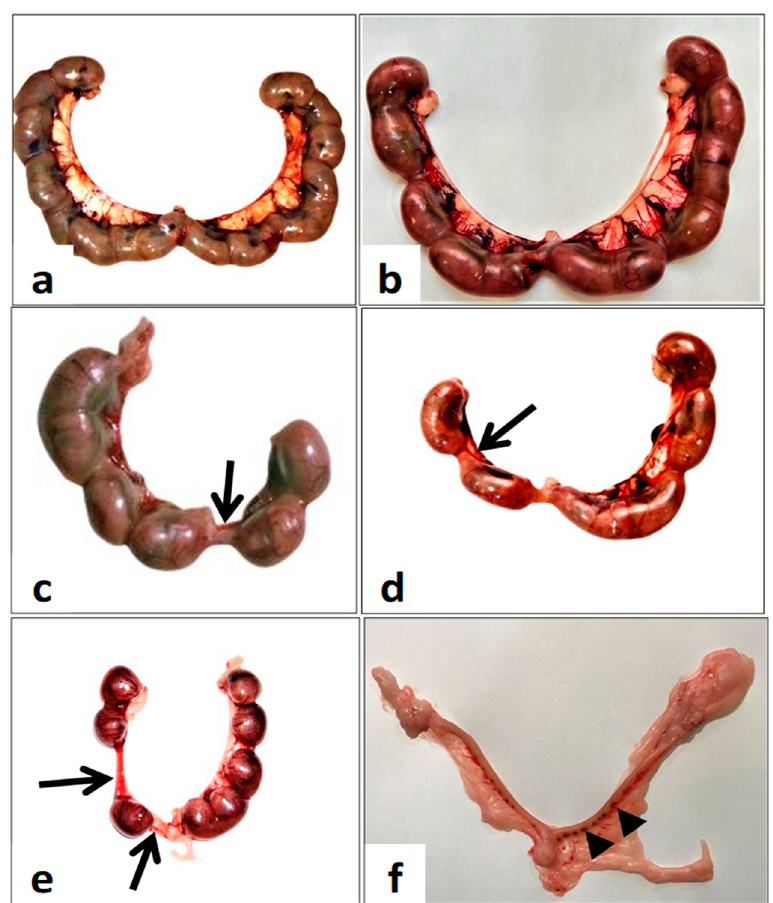
Figure 2. The whole mount of gravid uterine horns from pregnant rats was sacrificed on the 20th day of gestation. ( a , b ) The control group with full-term fetuses. ( c ) group I (day 0–7) show missed and resorbed fetuses (arrows). ( d ) Group II (day 7–14) shows resorbed fetuses (arrows) and intrauterine growth retardation of fetuses (arrows). ( e ) Group III (day 0–20) show resorbed fetuses (arrows) and dead and retarded fetuses. ( f ) Postimplantation loss (arrowheads).